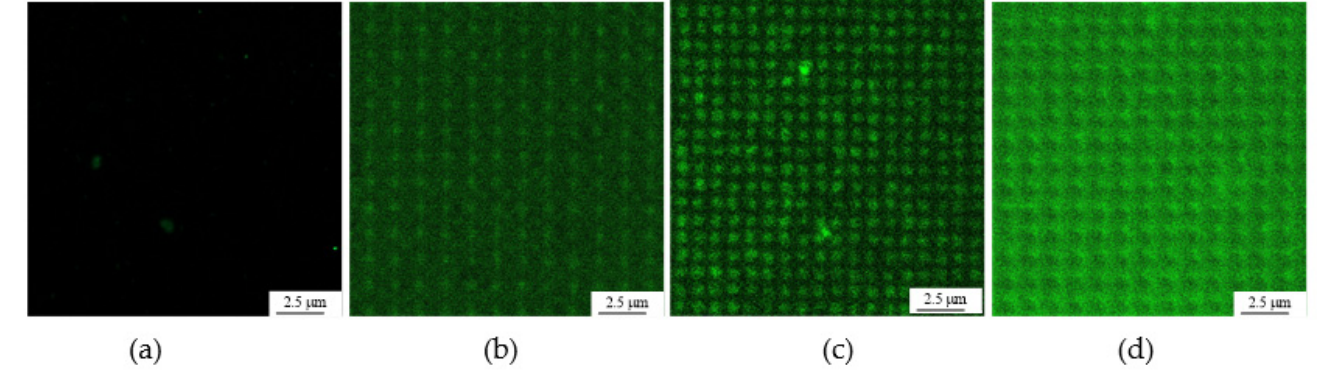
Figure 4. LSCM images of 500H-P(MAA-DB)-BDA on the silicon substrate after ROS-triggering for ( a ) 0, ( b ) 6, ( c ) 12, and ( d )18 h.